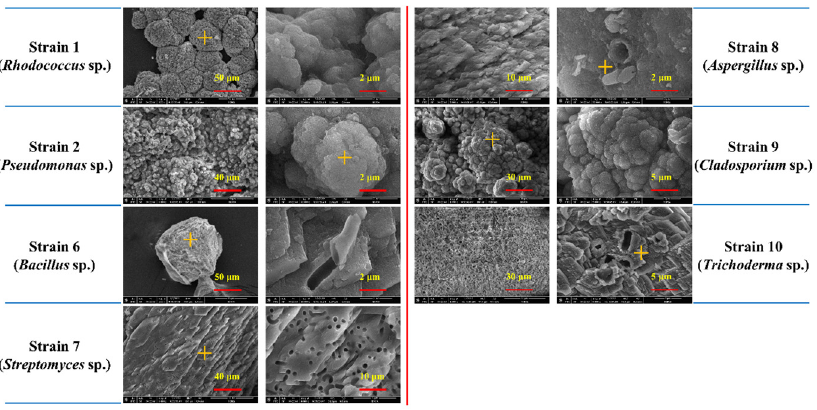
Figure 5. Scanning electron microscopy of the minerals formed by the strains. The yellow cross represents the location of the EDS analysis performed. Table 2. Mineral element composition and crystal composition of precipitates.